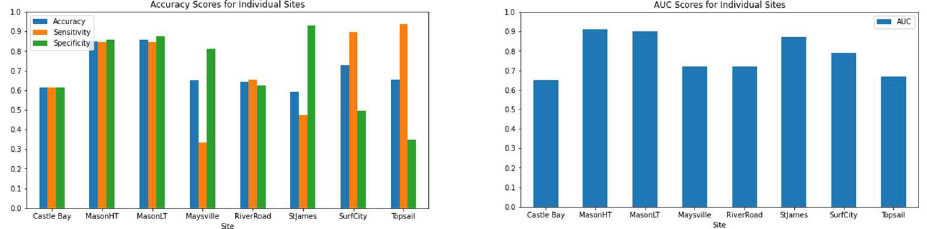
Figure 10. Performance metrics (Accuracy, Sensitivity, Specificity, and AUC scores) for XGBM.